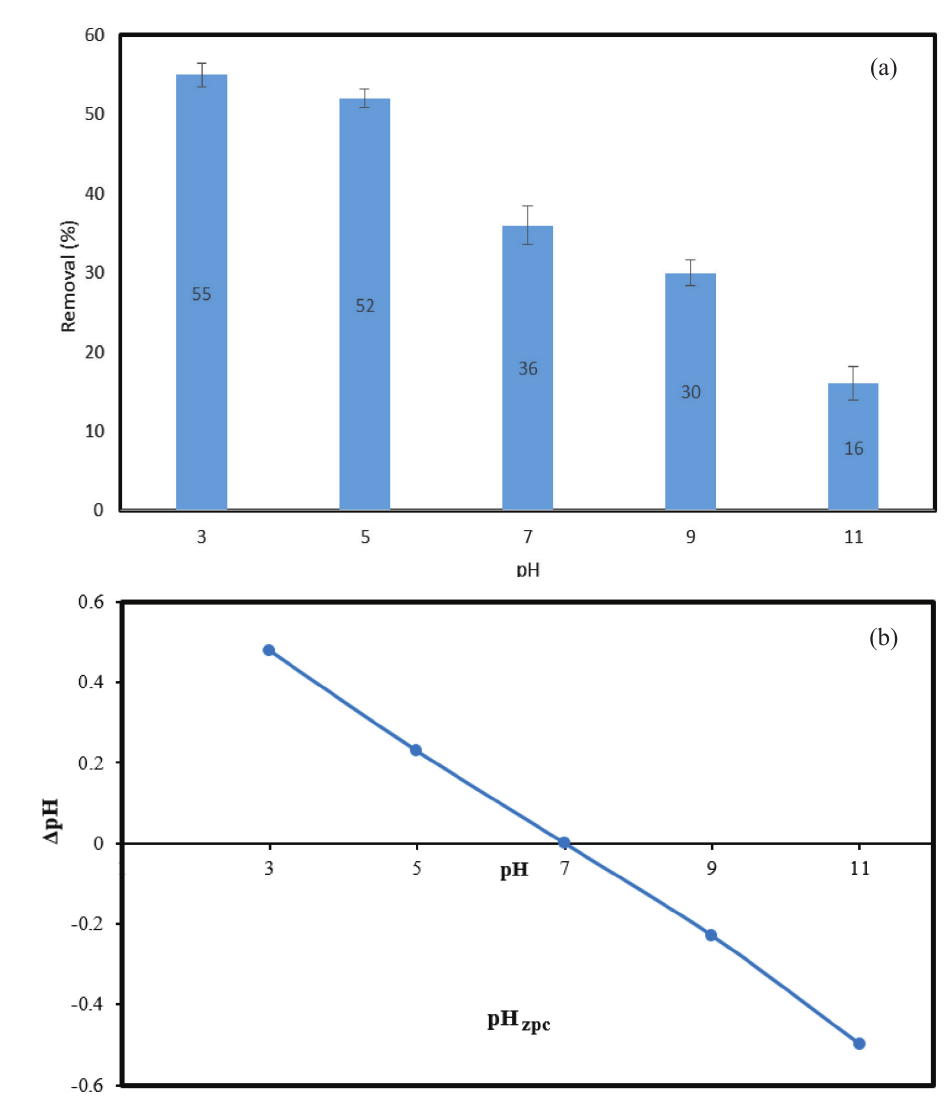
O nanoparticles, carbon support, and Fe@C 3 4